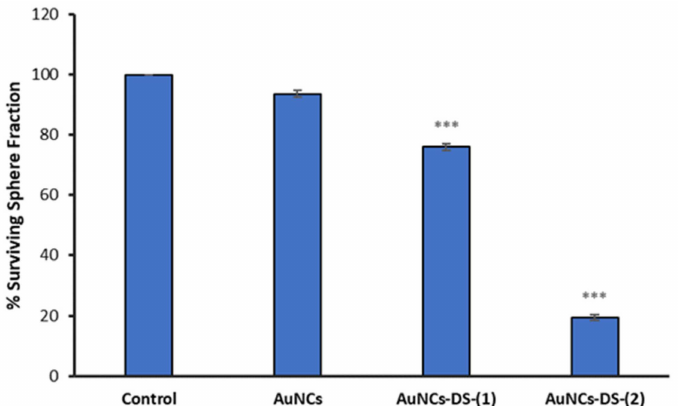
Figure 9. Surviving fraction of mammospheres treated with AuNCs for 7 days. Data correspond to mean ± S.D. values from three experiments. Statistical analysis was performed using one-way ANOVA Tukey’s test (each group vs Control). *** p <